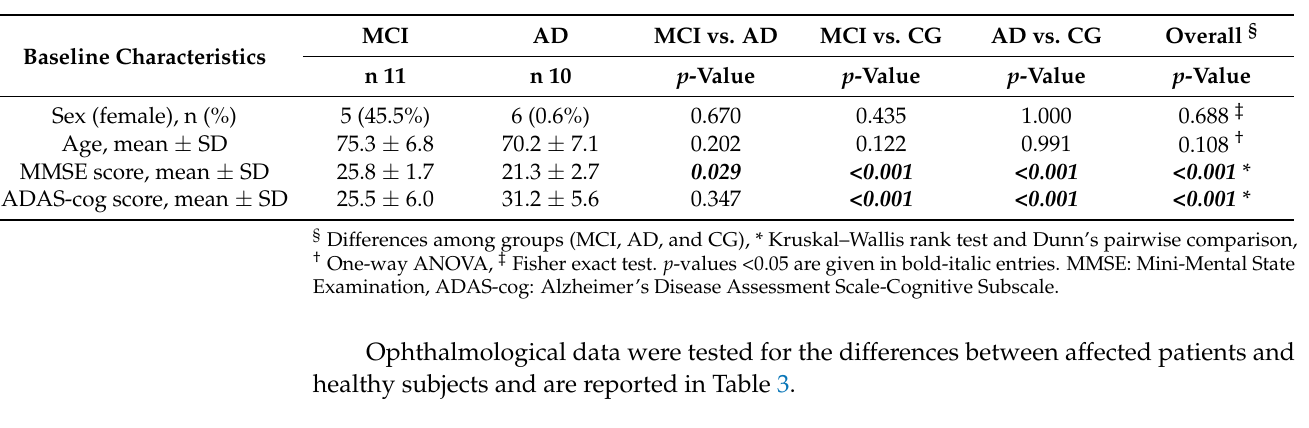
Table 2. Demographics and clinical characteristics stratified by mild cognitive impairment due to